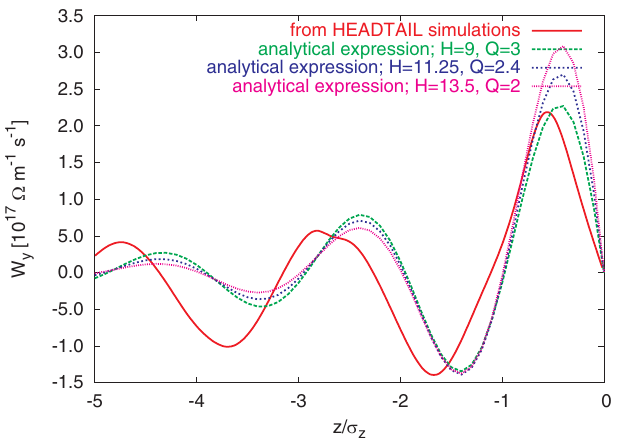
(cid:2) e FIG. 18. (Color) Emittance growth in LHC at injection: resona- (cid:2) 9 and Q (cid:2) 3 (dotted lines) and HEADTAIL tor model with H enh PIC module (full lines) for various electron-cloud densities.